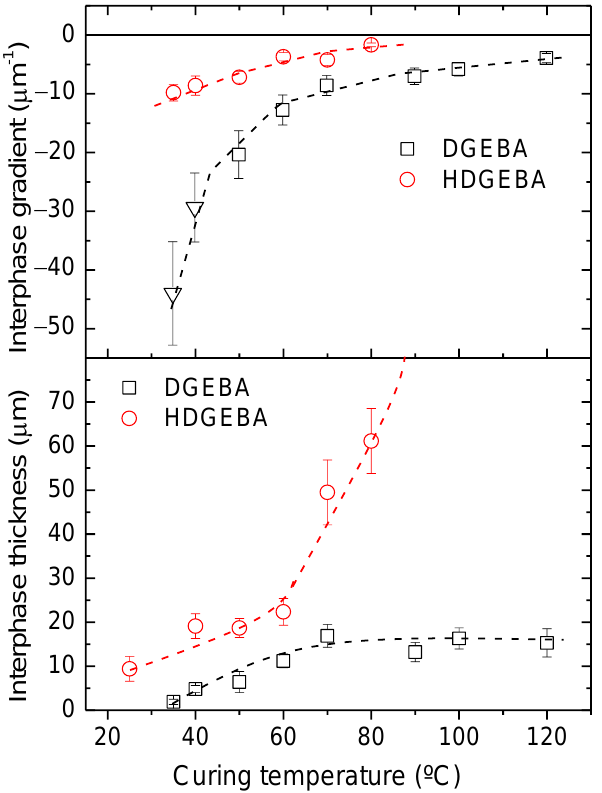
Figure 3. Compositional gradient and interphase thickness for samples containing DGEBA and HDGEBA cured up to the limiting conversion at several temperatures. Error bars correspond to the standard deviations of 10 different images at each curing temperature. Lines are eye − guides.